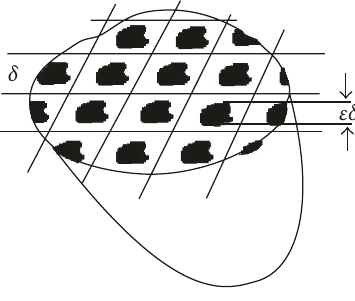
Figure 2.2 . Spatial